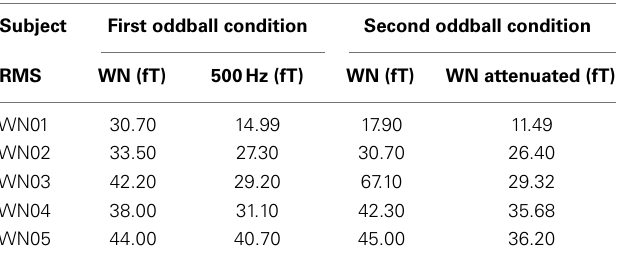
Table 1 | RMS values of the neonatalAERs for both oddball conditions applied in the second stimulation